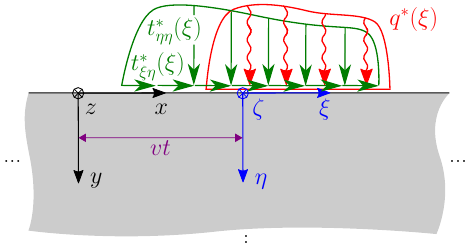
Figure 1. Half-space loaded by a distributed surface heat flux q ∗ ( ξ ) and normal and tangential surface ( ξ ) . Assuming a quasi-stationary problem, the distributions are constant in time tractions t ∗ ηη ( ξ ) , t ∗ ξη in the ξ - η - ζ -system that moves at constant velocity v in the ξ -direction w.r.t. the material coordinate system x - y - z . The coordinate axes pointing into the plane are denoted by ζ and z , respectively. The assumption of plane-strain implies zero total normal strain along these axes, i.e., ε ζζ = ε zz =